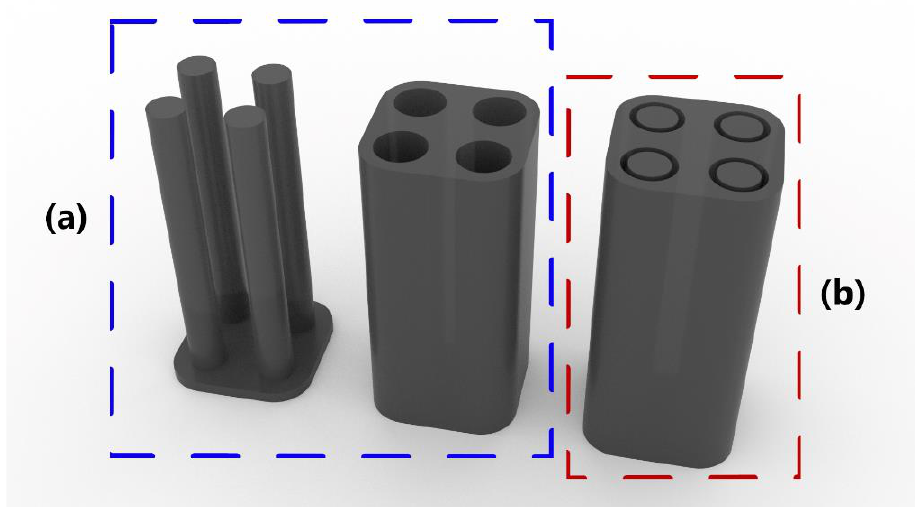
Figure 6. Ureter mold designs ( a ) Two-part mold, the mold is separated after curing ( b ) Original single part mold, ureters were difficult to remove from this.